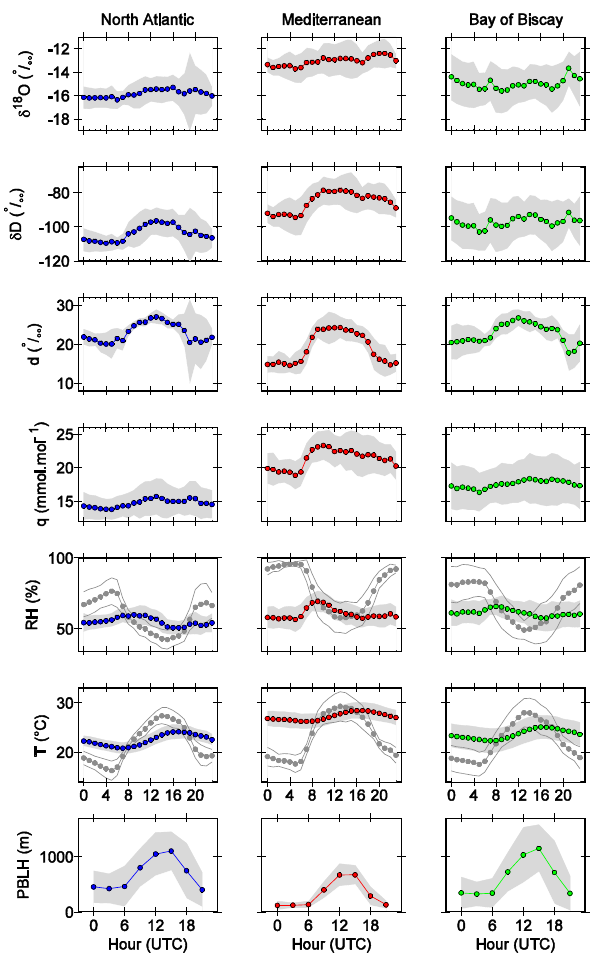
Figure 5. Average daily cycles of δ 18 O, δ D, deuterium excess ( d ), relative humidity at surface (RH s ) and air (RH a , grey symbols) tem- perature, surface ( T s ) and air ( T a , grey symbols) temperature, mix- ing ratio ( q ) and planetary boundary layer height (PBLH) calculated from 20 July to 24 August 2011 according to the three air mass origins. Grey shading indicates standard deviation of each average